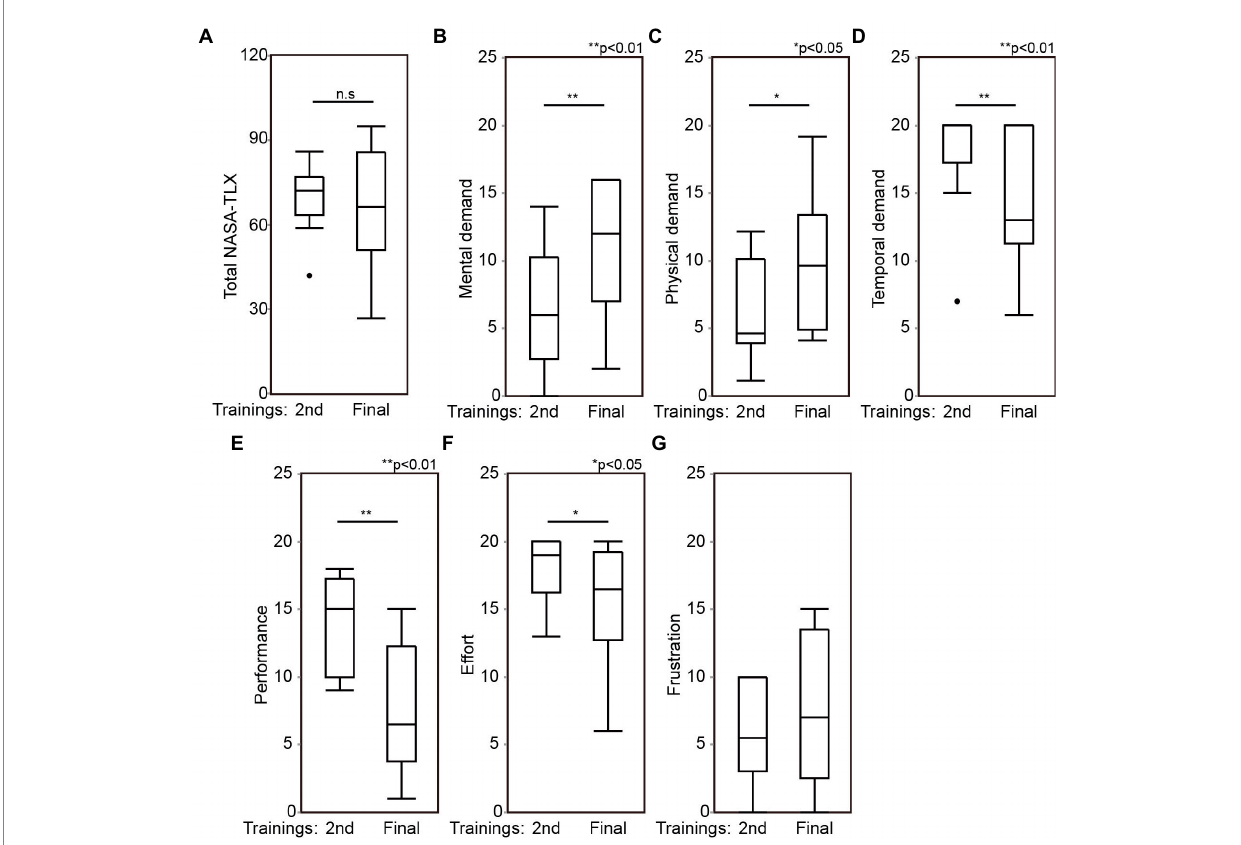
FIGURE 5 Registrars’ mental workload during ESS before and after the repetitive training. After the first simulation surgeries, 10 registrars repeated surgeries more six times. Total score of NASA-TLX (A) , mental demand (B) , physical demand (C) , temporal demand (D) , performance (E) , effort (F) , and frustration (G) were compared between 2nd training and the final training, which the same models were used. ESS, Endoscopic sinus surgeries; NASA-TLX, national aeronautics and space administration-task load index. 2nd, the 2nd training; Final, the final